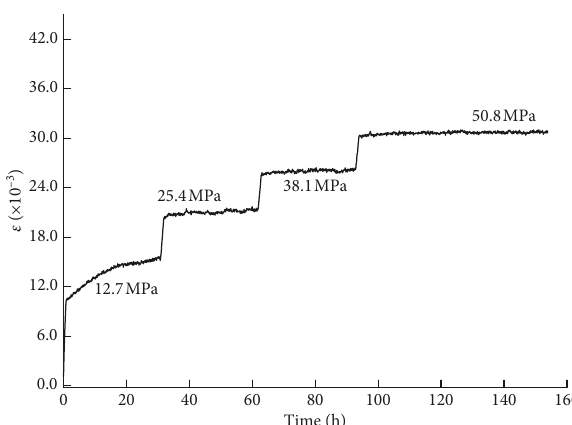
Figure 4: Creep curve: the confining pressure is